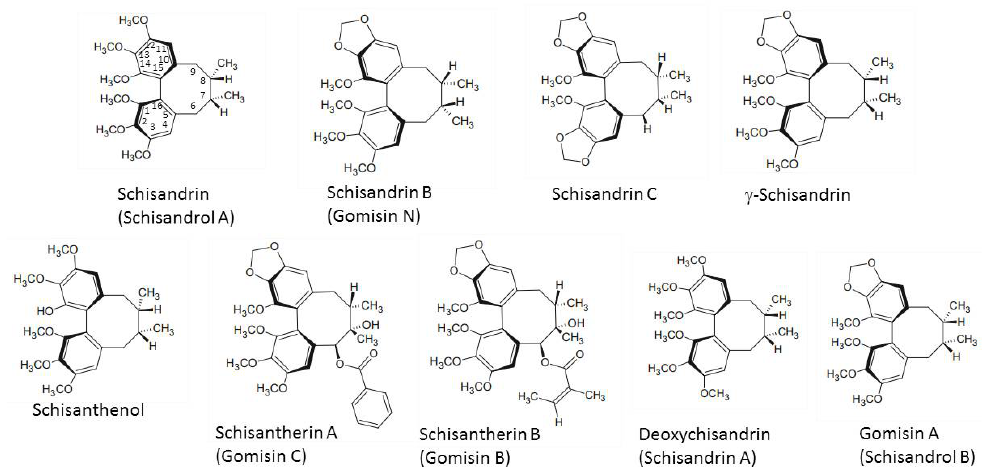
Figure 1. Chemical structures of main Schisandra chinensis lignans.